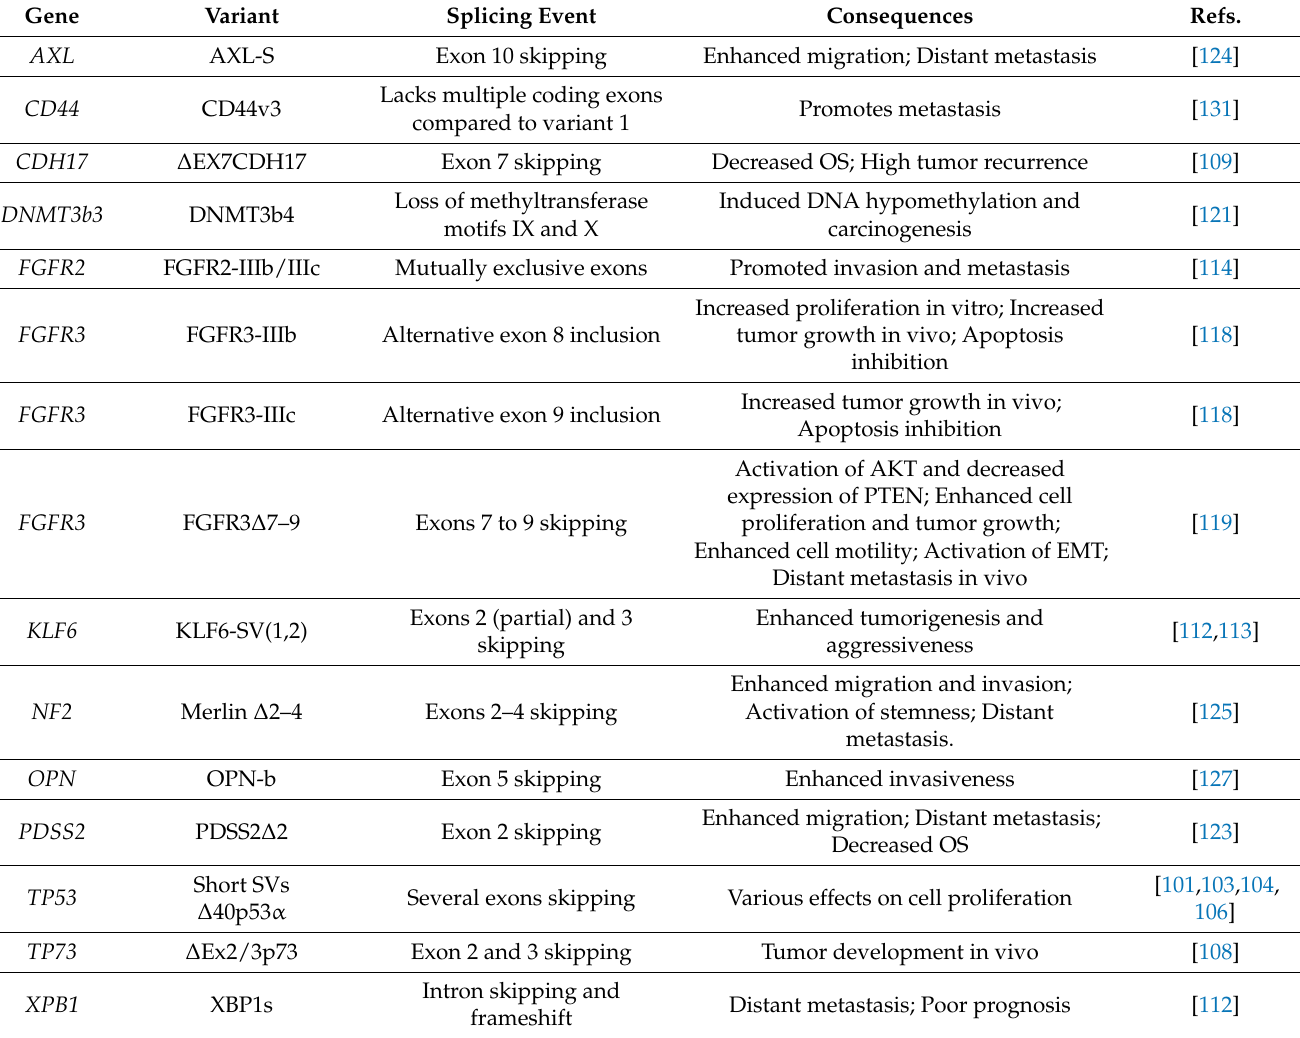
Table 2. Alternative splicing of genes involved in hepatocellular carcinoma development and metastasis.